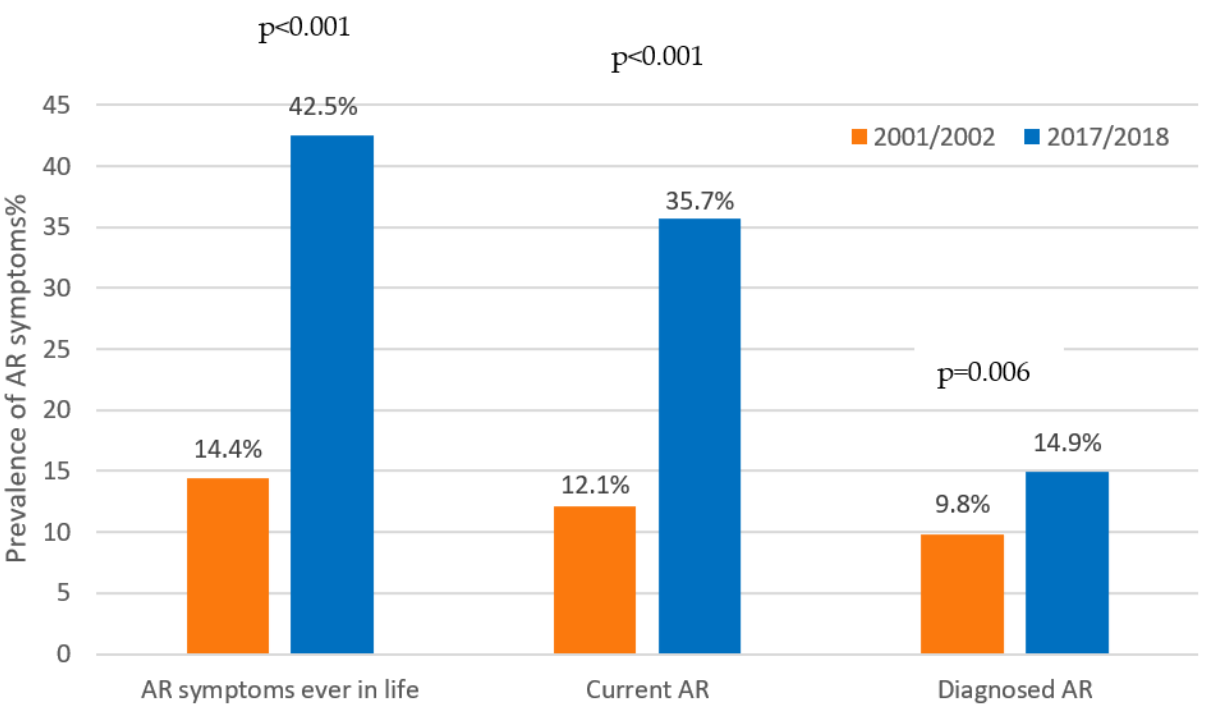
Figure 2. Significant rise in the self-reported prevalence of AR symptoms and diagnoses, 2002 – 2018. The self-reported prevalence of current AD in 2018 was 18.1%. The symptoms of AD ever-in-a-lifetime increased by 19% ( p < 0.001), current AD by 10% ( p < 0.001) and self- reported AD diagnoses by 20% ( p = 0.001) in comparison with the previous study (Figure 3).